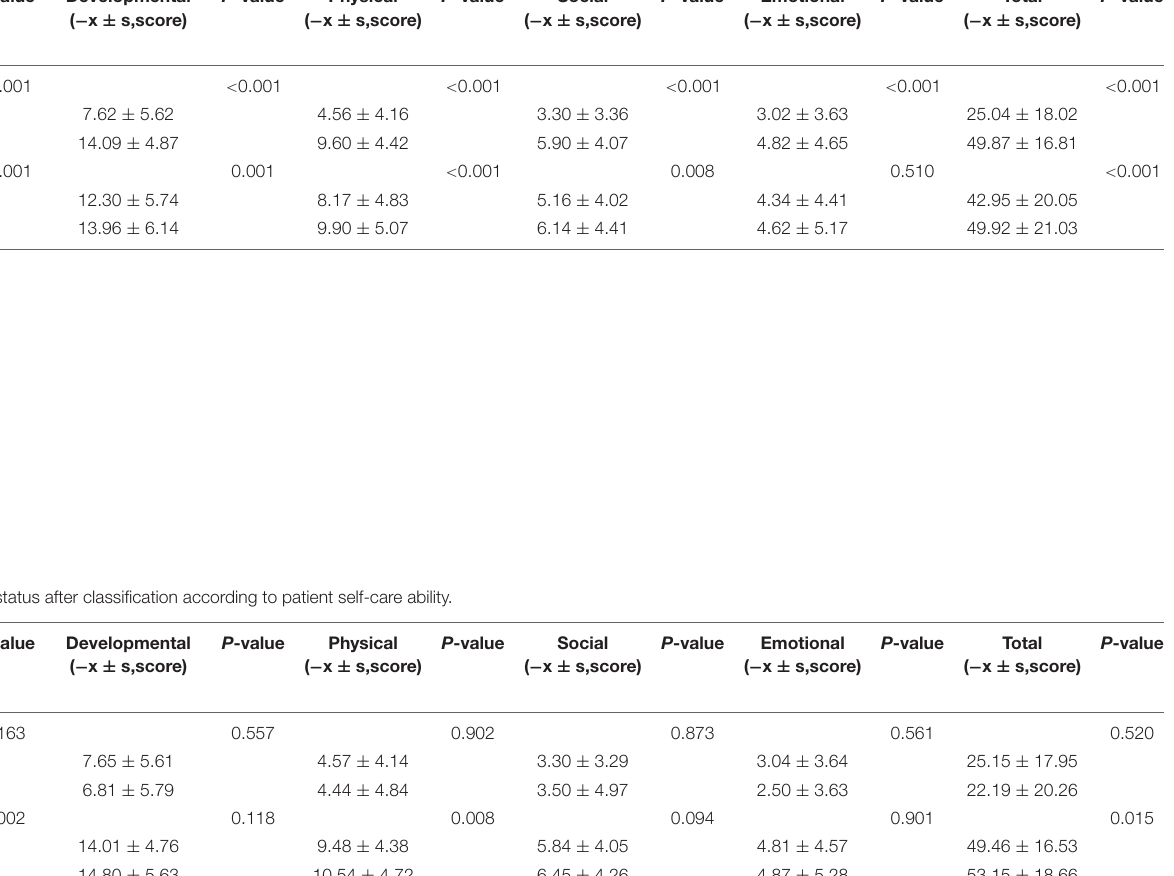
Self-care ability